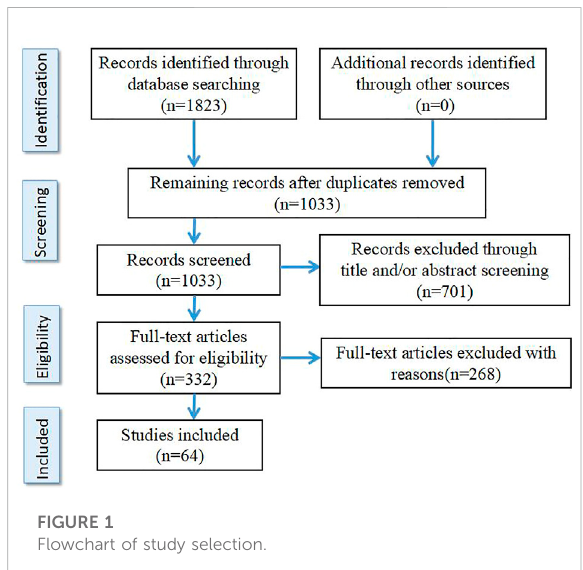
FIGURE 1 Flowchart of study